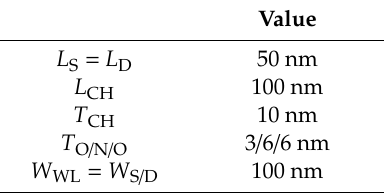
Table 2. Physical parameters of the device used for electrical